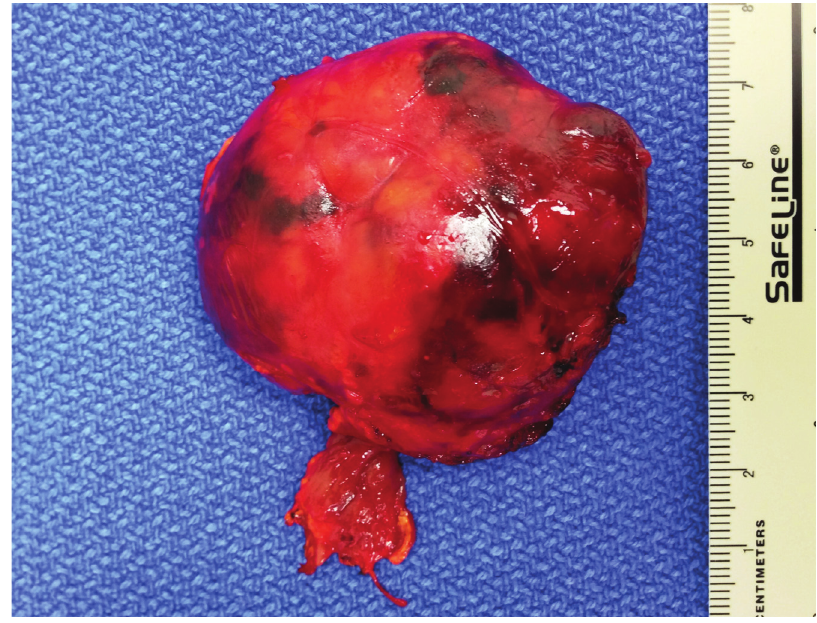
Figure 2. Specimen with adjacent part of left adrenal gland after retroperitoneoscopically performed tumor